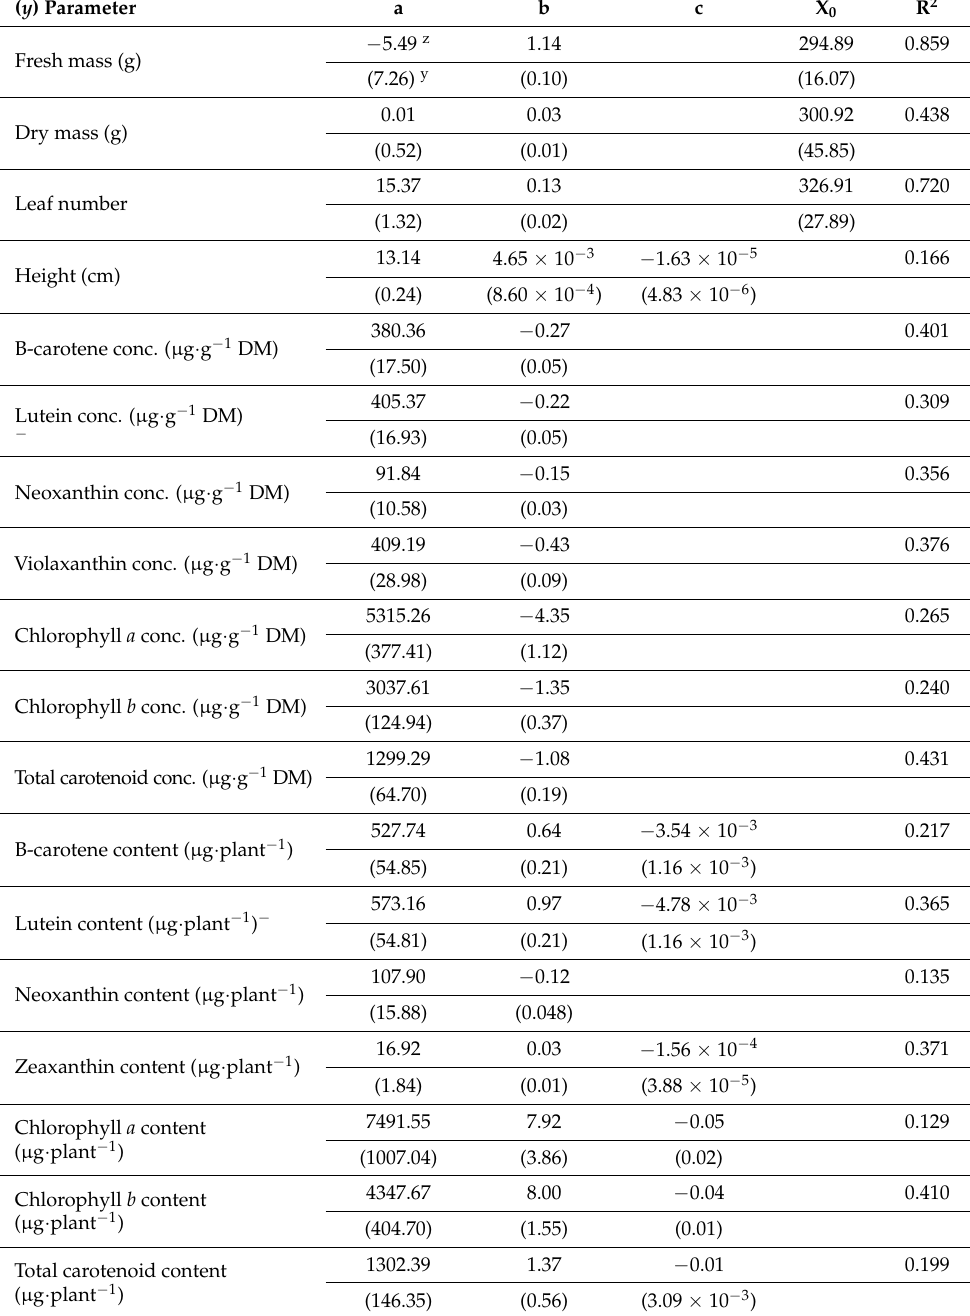
z Coefficients for model equations used to generate Figures 4–6. Linear: y = a + b x . Quadratic: y = a + b x + c x 2